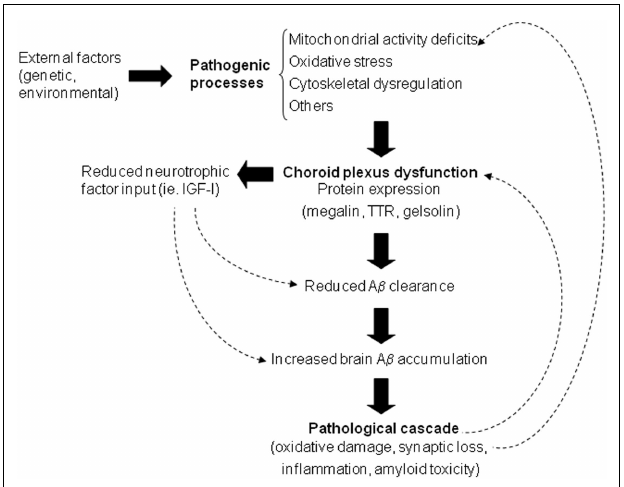
FIGURE 1 | Proposed sequence of pathological processes involved in Alzheimer’s disease. Various pathogenic processes contribute to the dysfunction of the choroid plexus which results in impaired A β processing. This and the resultant accumulation of A β can in turn feed back to enhance the pathogenic processes.